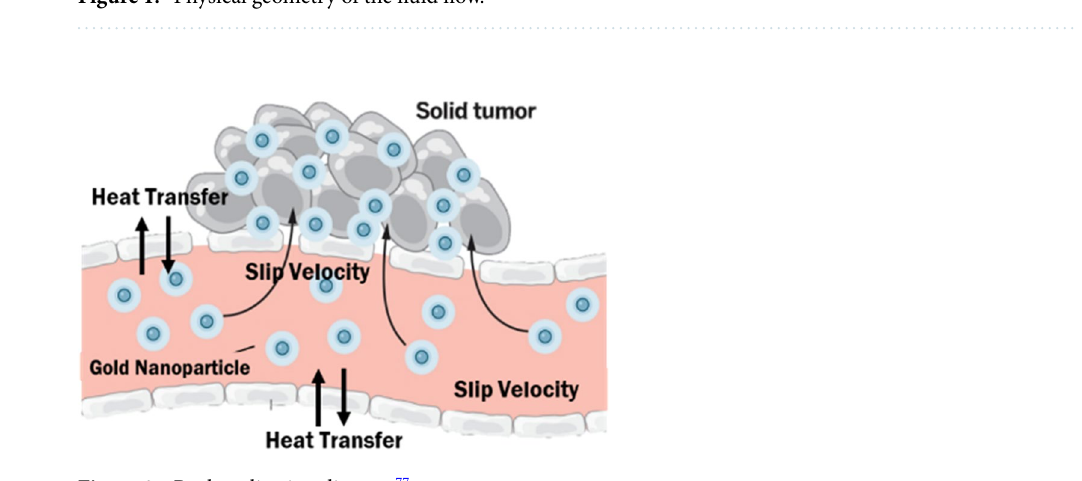
Figure 1. Physical geometry of the fluid flow.